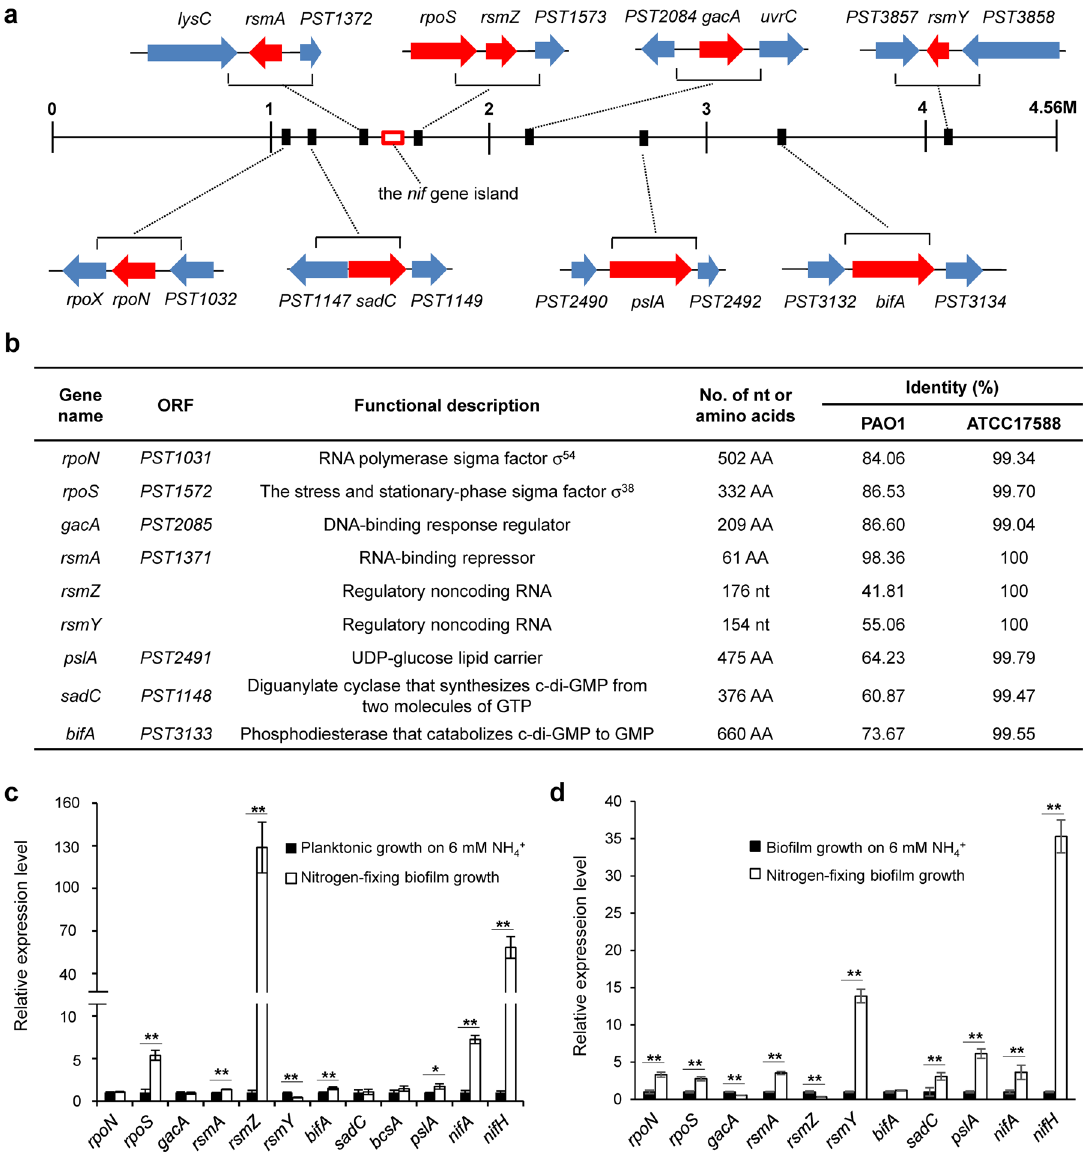
Fig. 2 Systematic investigation of the P. stutzeri A1501 genes possibly involved in bio fi lm formation. a Localisation of the gene clusters on a linear map of the chromosome. The 49 kb nif gene island (red box) is located on the chromosome (from PST1302 to PST1359). b Functional description. Identities (%) shared between the amino acid sequences of orthologous proteins from Pseudomonas aeruginosa PAO1 and P. stutzeri ATCC17588 are presented. c Relative expression levels of the selected genes in planktonic cells on medium K containing lactate and ammonium versus nitrogen- fi xing bio fi lm cells on medium K containing lactate. d Relative expression levels of the selected genes in bio fi lm cells on medium K containing lactate and ammonium versus nitrogen- fi xing bio fi lm cells on medium K containing lactate. Each error bar indicates the standard deviation of three independent experiments. Asterisks indicate statistical signi fi cance by one-way ANOVA with LSD multiple-comparison test: * p < 0.05; ** p <